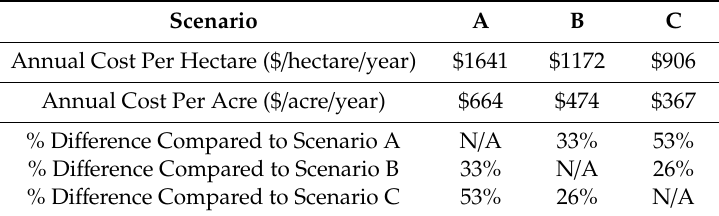
Table 11. Calculated percent difference between the annual cost per hectare and acre for scenarios A, B, and